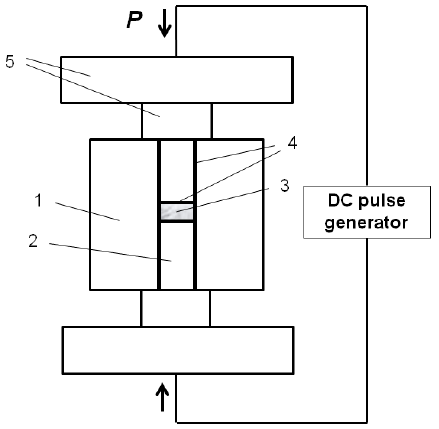
Figure 1. Schematic of the die/punch/spacer assembly used for pressureless Spark Plasma Sintering (SPS) experiments: ( 1 ) graphite die; ( 2 ) short graphite punches; ( 3 ) powder sample; ( 4 ) graphite foil; ( 5 ) graphite spacers.